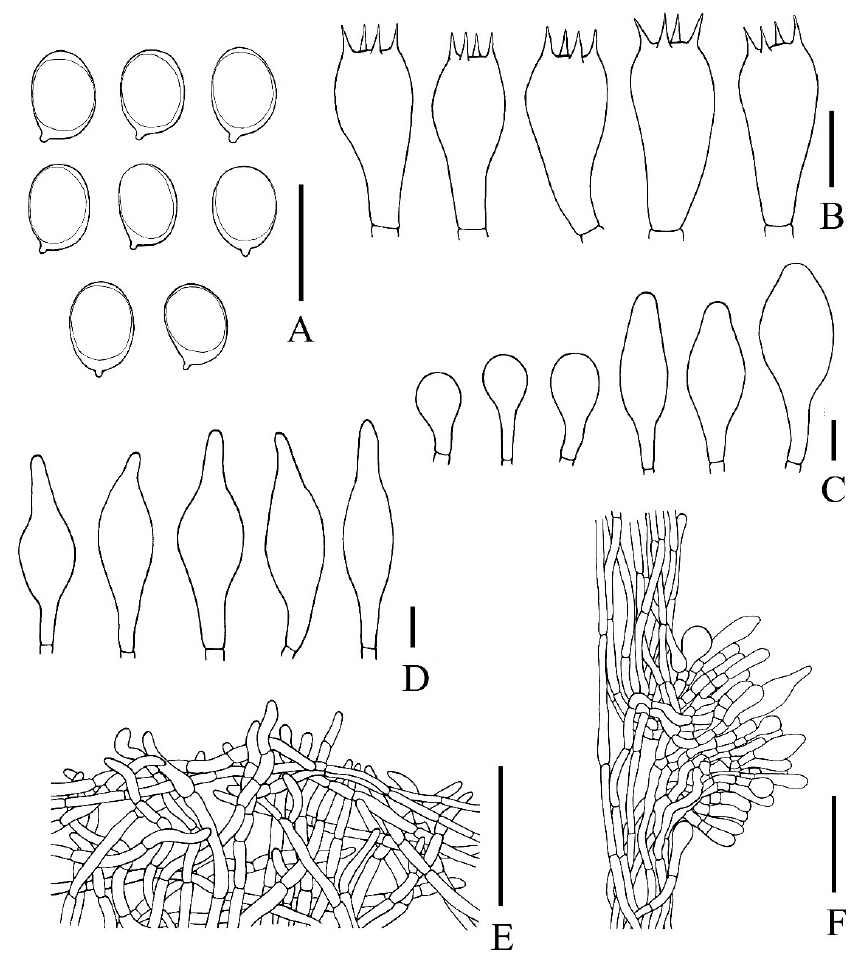
Figure 4 . Scanning electron micrographs of Rubinosporus auriporus basidiospores from the holotype—Bar = 1 µm.